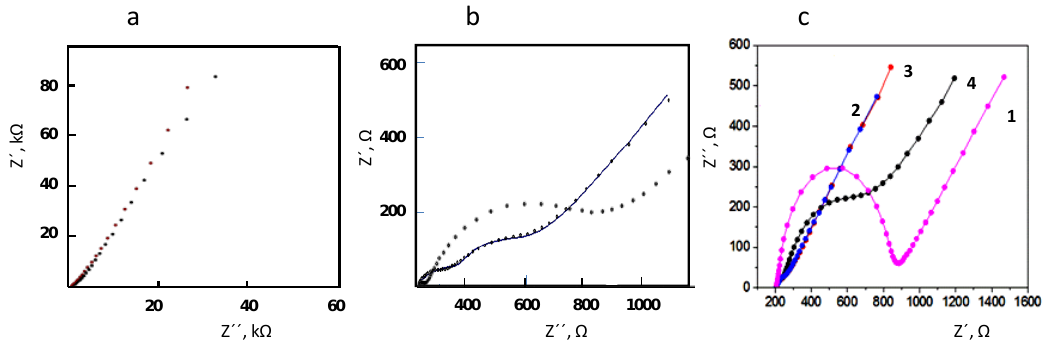
Figure 4. Effect of pH on the biosensor response. See the text for more information.